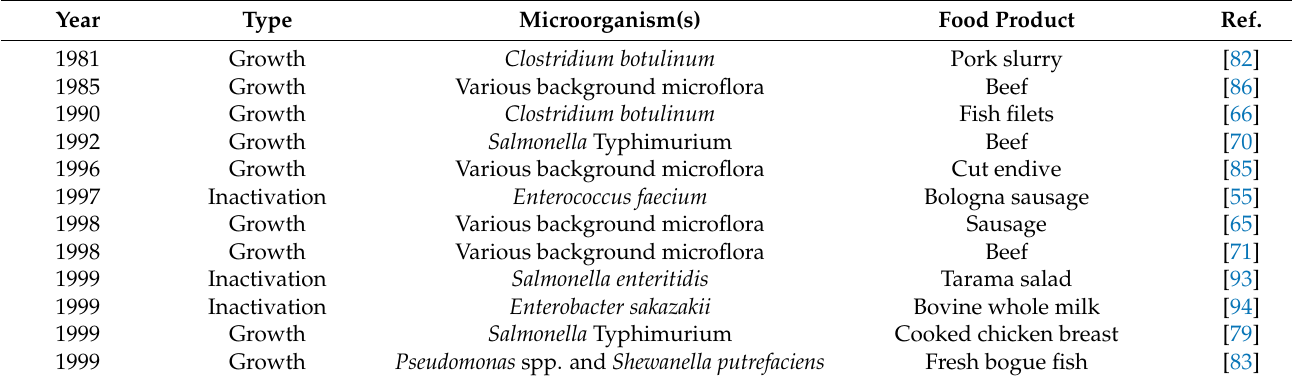
Table 1. Examples of studies (ordered chronologically) in which predictive models only valid for specific food products were